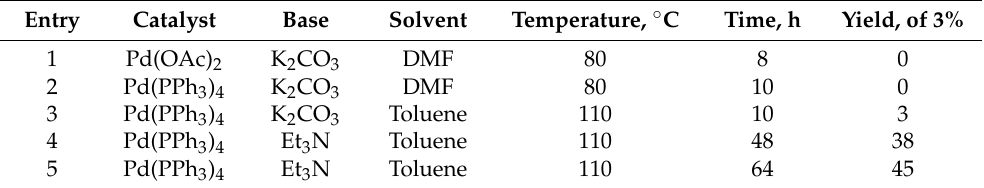
Table 1. Reaction of 4,7-dibromo[1,2,5]thiadiazolo[3,4- c ]pyridine 2 with N , N -diphenyl-4- vinylaniline 3 .